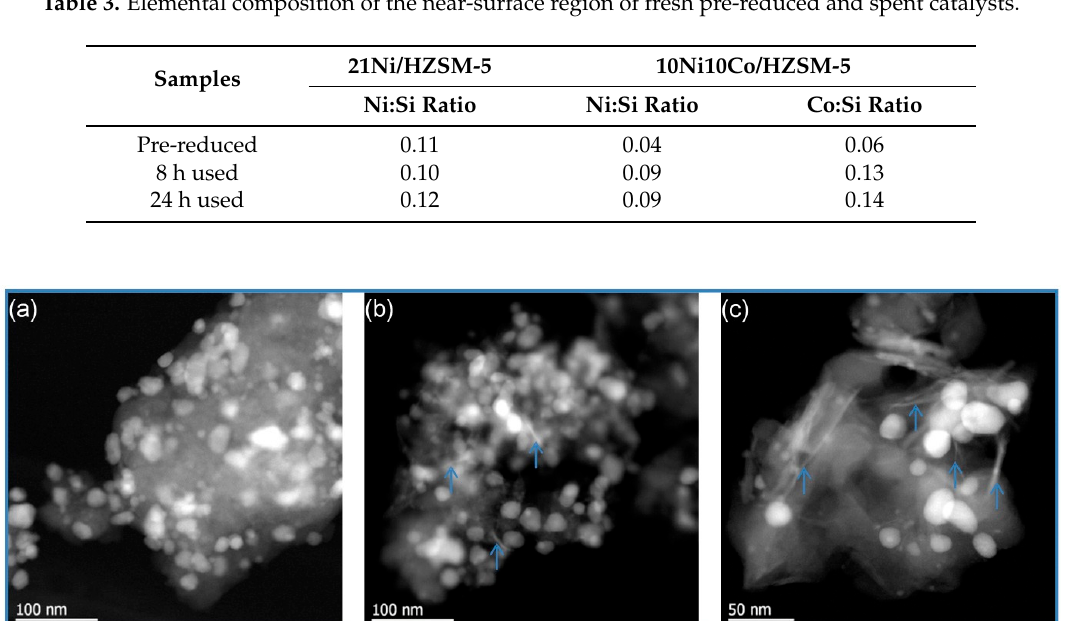
Figure 5. TEM images of 21Ni/HZSM ‐ 5. ( a ) Pre ‐ reduced; ( b ) after 8 h on ‐ stream and ( c ) after 24 h on ‐ stream (arrows indicate the band particles). Although both catalysts showed a change in metal particle sizes and the formation of band ‐ like particles, the effect was much more pronounced in the case of 21Ni/HZSM ‐ 5 compared to 10Ni10Co/HZSM ‐ 5. This is also in line with the crystallite size derived from XRD (see Table 2). It can be concluded that the presence of Co slows down the crystal growth and stabilizes the Ni active sites during the long ‐ term reaction owing to the formation of Ni ‐ Co alloy.